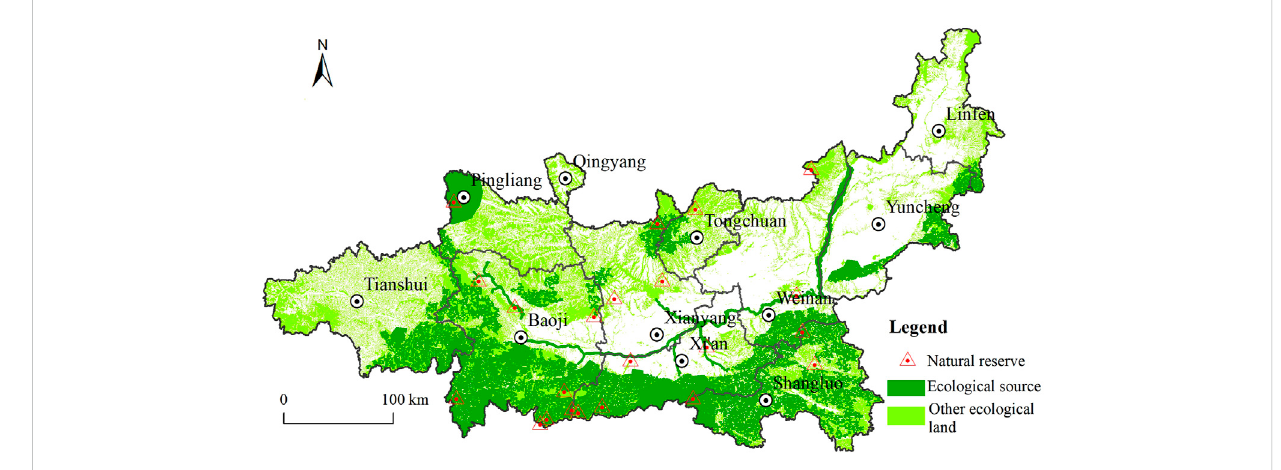
FIGURE 7 Spatial distribution of ecological